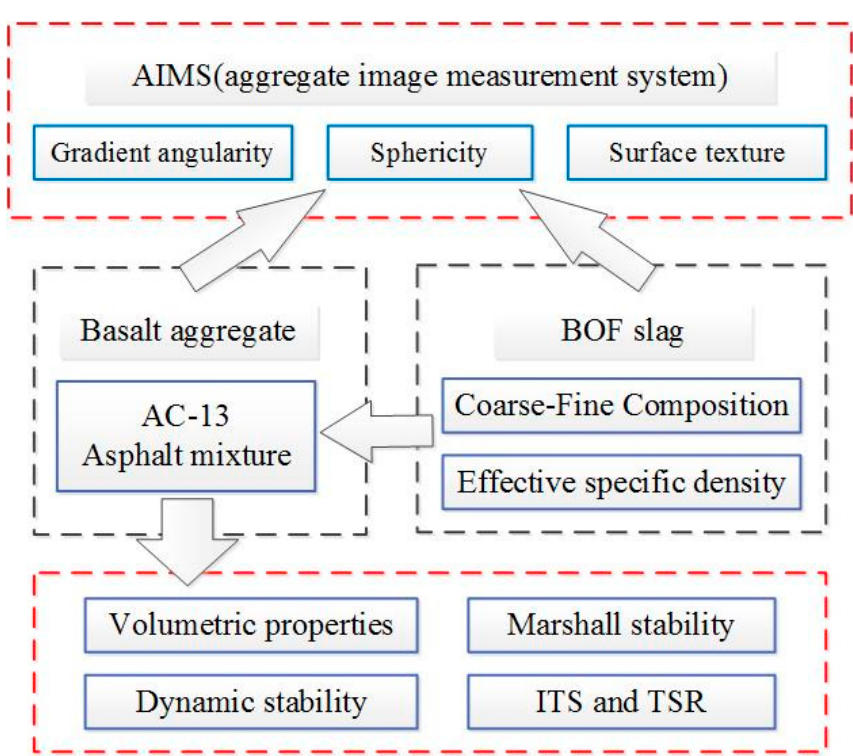
Figure 5. Finalized research